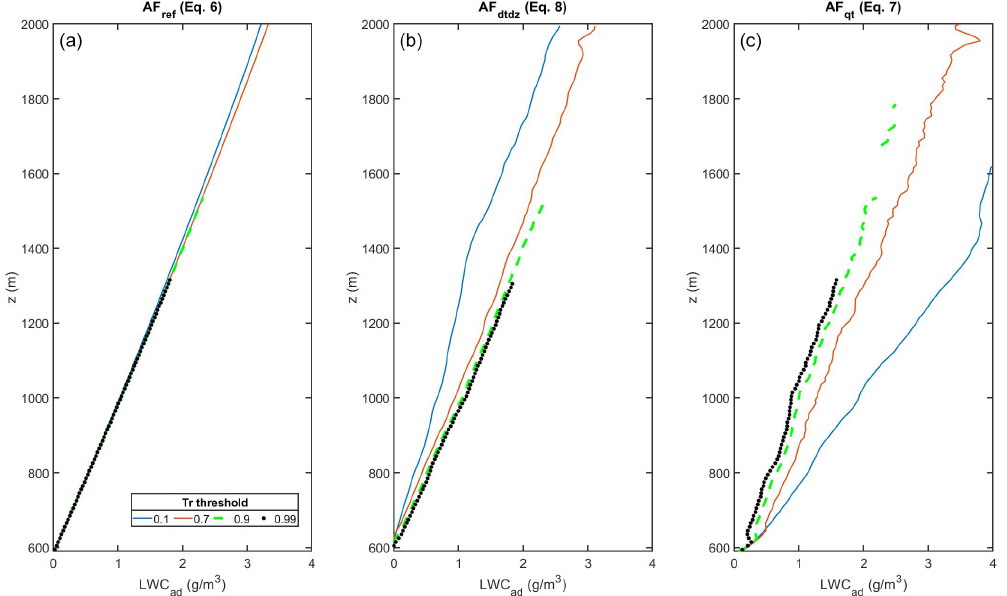
Figure A2. LWC ad profiles of different approaches for different estimations of adiabatic profiles. LWC ad (z) was calculated according to Eqs. (6, a ), (8, b ), and (7, c ). Taken from a snapshot of a cloud with an aerosol concentration of 500cm − 3 at the time of maximal development (33min). The temperature and humidity profiles were used by averaging all points of each layer according to a certain threshold on sub-layer tracer normalized concentration (Tr). Black dots are for nearly pure undiluted parcels with Tr > 0.99, the green dashed line is for nearly adiabatic parcels (Tr > 0.9), and red and blue curves also include slightly (Tr > 0.7) and strongly diluted (Tr > 0.1) parcels. It is shown that there are no pure adiabatic parcels above the inversion. Nevertheless, the use of slightly diluted parcels (with Tr > 0.7) in our chosen reference method (Eq. 6) does not introduce large biases to LWC ad and AF